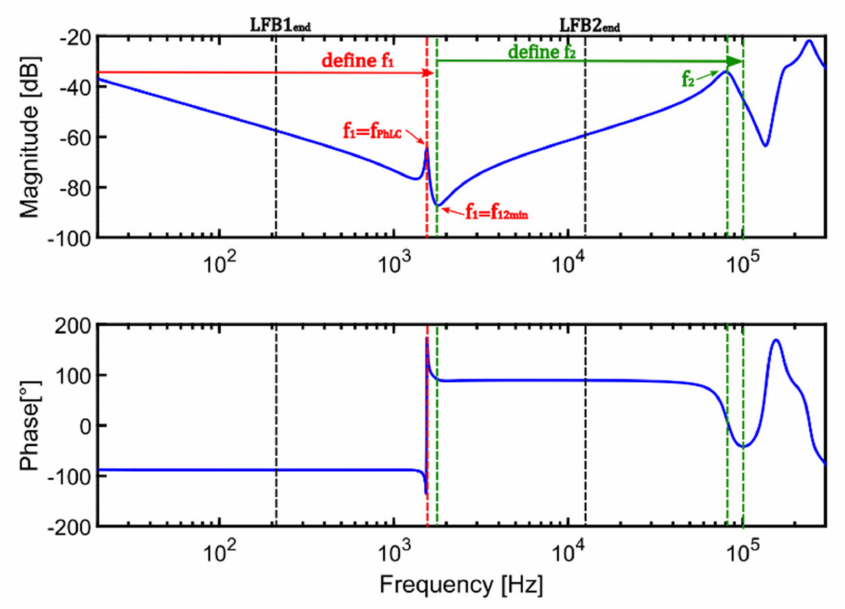
Figure 9. An example of class 3 FRA plot for identification of the LFB1 end and LFB2 end